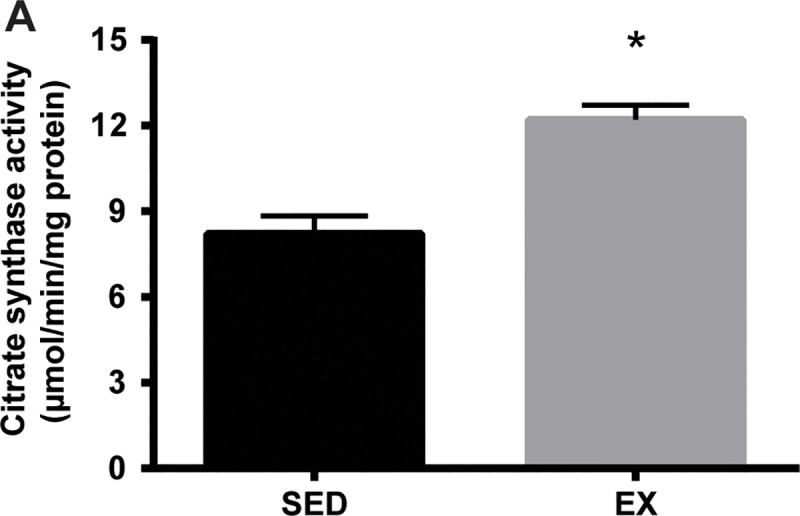
Increased citrate synthase activity in gastrocnemius muscle from EX mice.Gastrocnemius muscle was homogenized as described in the methods section. Citrate synthase activity in muscle homogenate was determined by measuring the production of SH-CoA from the condensation of dicarboxylate oxaloacetate and acetyl CoA by citrate synthase (n = 8 per group). The data are expressed as μmol/min/mg protein. *p < 0.001 compared to SED mice.